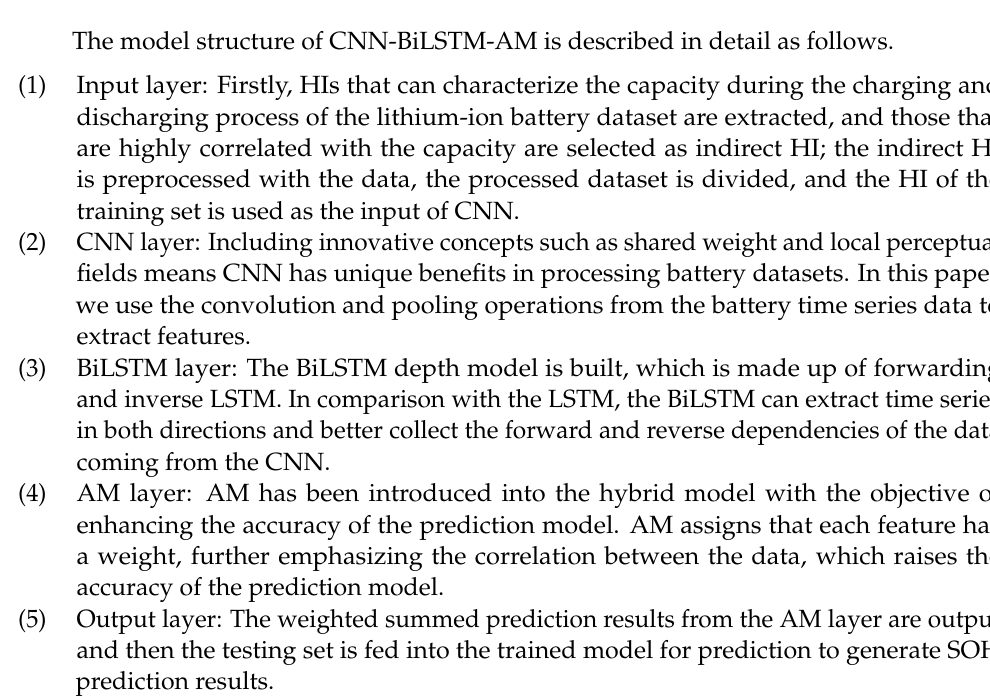
Figure 6. Structure diagram of CNN-BiLSTM-AM.